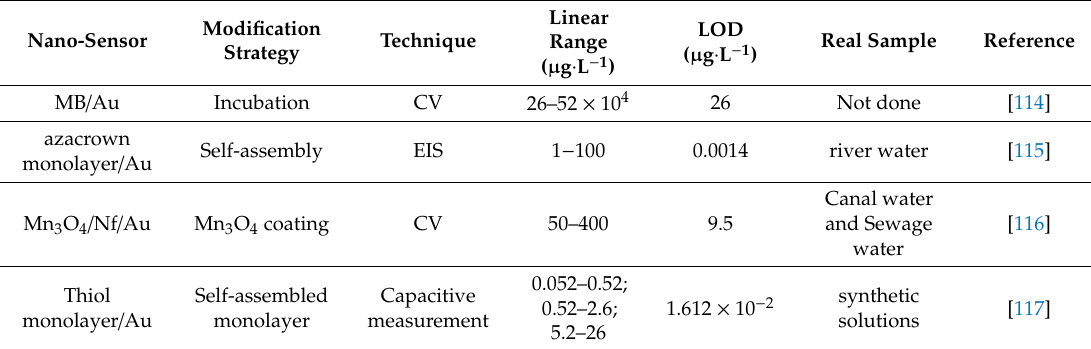
Table 5. Summary of the electroanalytical data of reported modified gold solid electrodes for hexavalent chromium